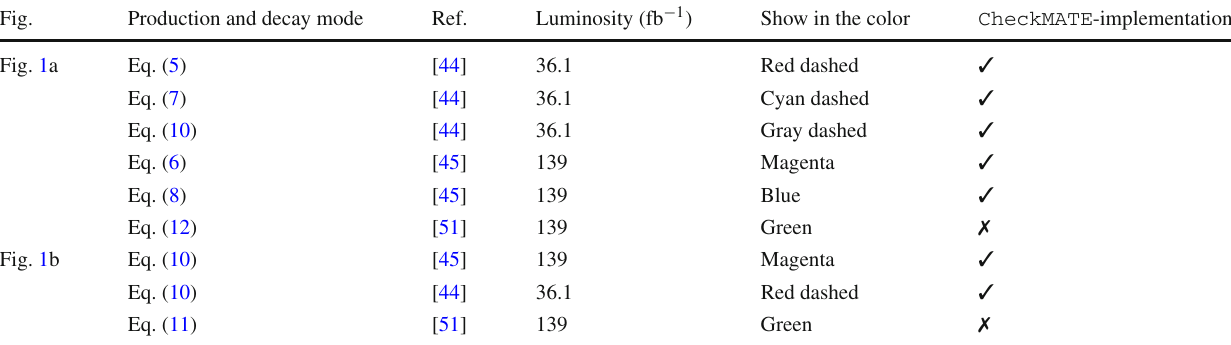
Table 1 Table showing the relevant constraints from the LHC imposed to our parameter space. The last column specifies which analyses have been implemented by us into CheckMATE Fig. Production and decay mode Ref. Luminosity (fb − 1 ) Show in the color CheckMATE